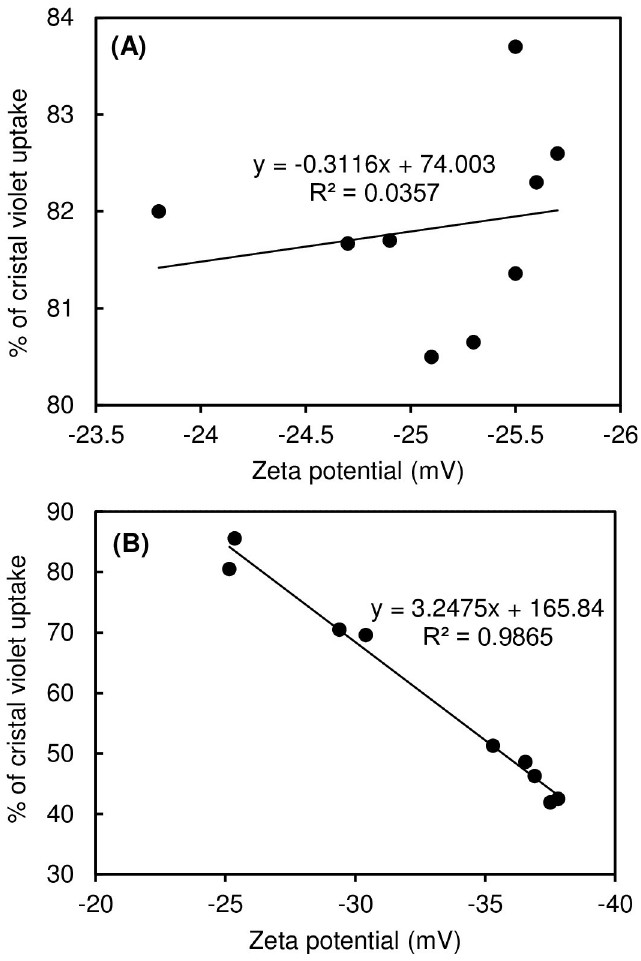
Fig 8. Correlation of membrane permeability with zeta potential of R . cerastii IEGM 1278. Cells were grown in the RS medium supplemented with 0.1% n -hexadecane (A) and 100 mg/L IBP and 0.1% n -hexadecane (B).